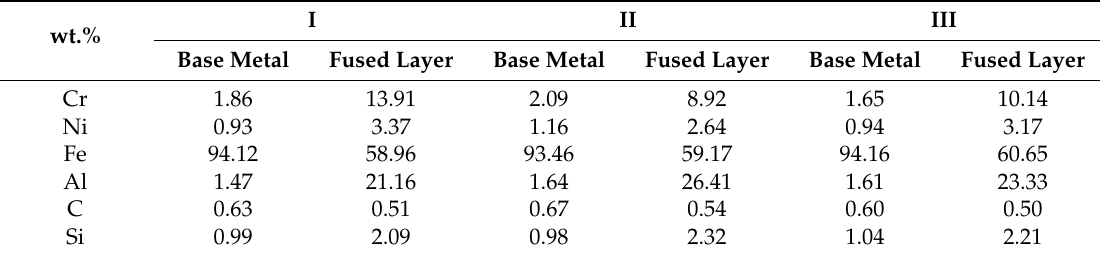
Table 3. Content of all elements: I (CC 0.2 m/min), II (CC 0.3 m/min) and III (PC 0.2 m/min). Wt.%